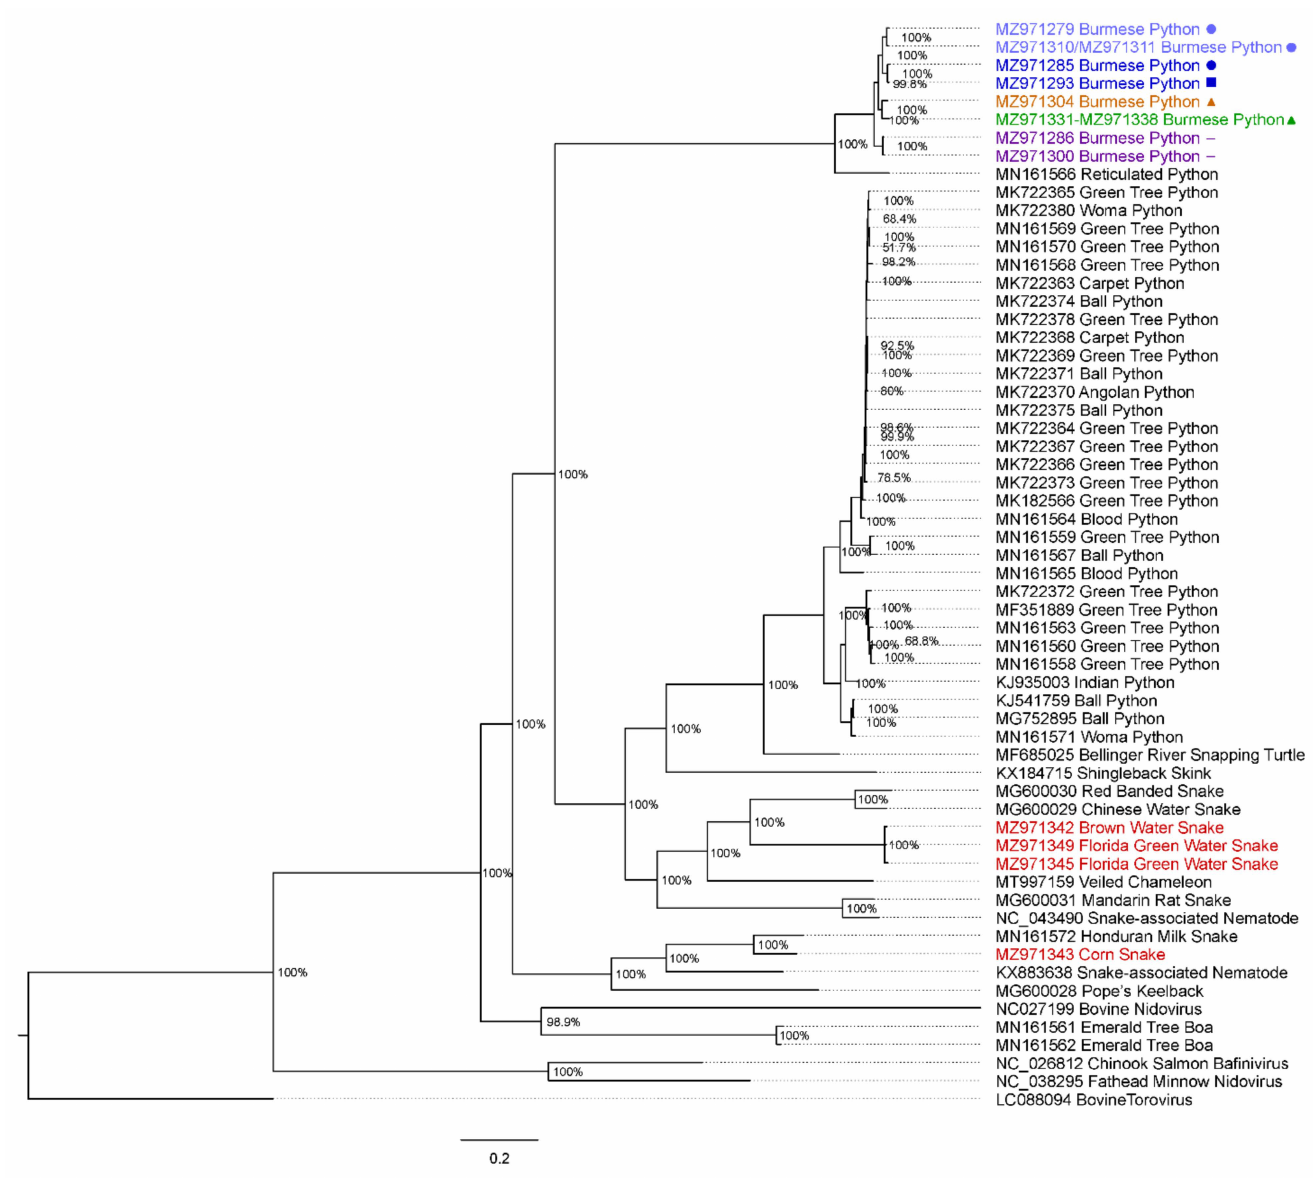
Figure 3. Bayesian phylogenetic tree of the translated ORF1b gene of southern Florida, USA snake serpentoviruses. Novel Burmese python serpentoviruses are highlighted as follows: clade 1A (navy blue), clade 1B (light blue), clade 2 (purple), clade 3 (orange), and clade 4 (green). Samples came from 4 subpopulations within the state of Florida, USA: western (triangle), northern (diamond), central (square), and southern (circle). Highlighted in red are novel Florida native colubrid serpentoviruses. In black text are previously described viruses published to GenBank. Bovine Torovirus (LC088094) was used as an outgroup. Bayesian posterior probabilities are shown at branch points. The scale at the bottom represents expected substitutions per